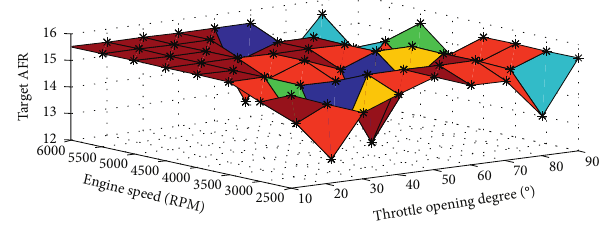
Figure 17: Fuel injection MAP.